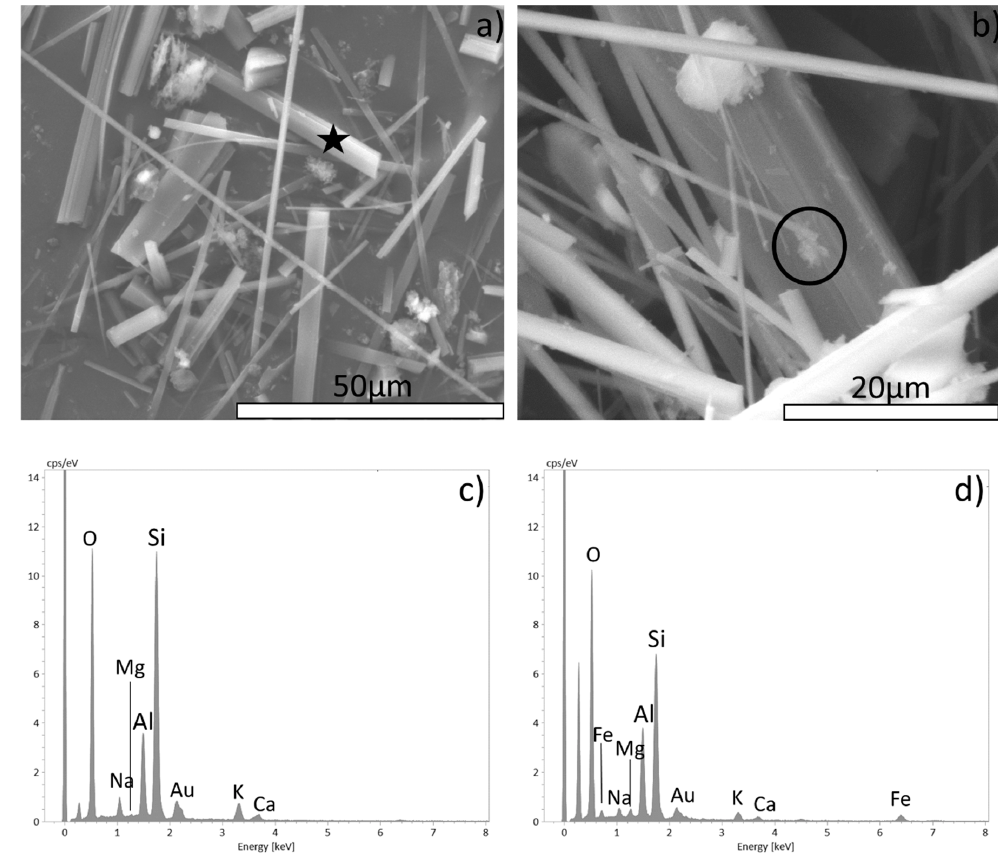
Figure 4. Gallery of SEM pictures and relative EDX spot analyses of the Poona sample. ( a ) Poona sample with acicular mordenite crystals: ( b ) Poona mordenite with microparticles enriched in iron present at the surface of the fibers. ( c ) Typical EDX spectrum recorded on mordenite surface free from the particles. No iron was found. ( d ) Representative EDX spectrum of the microparticles present in the fibers surface. A peak produced by iron is observed.